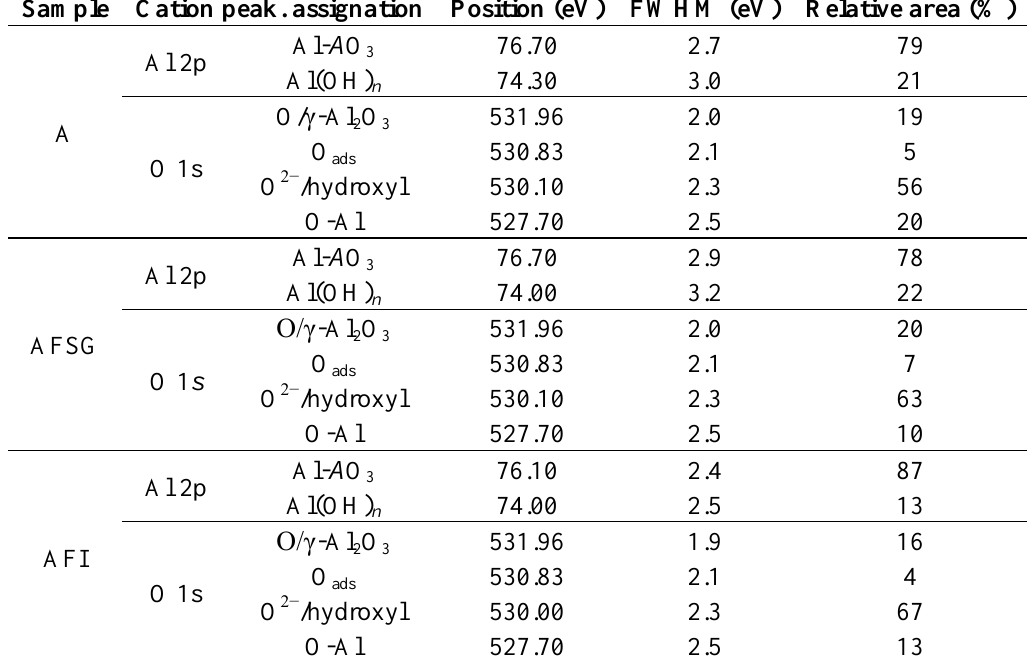
Table 2. Deconvolution parameters for the alumina catalysts; FWHM: Full width at half